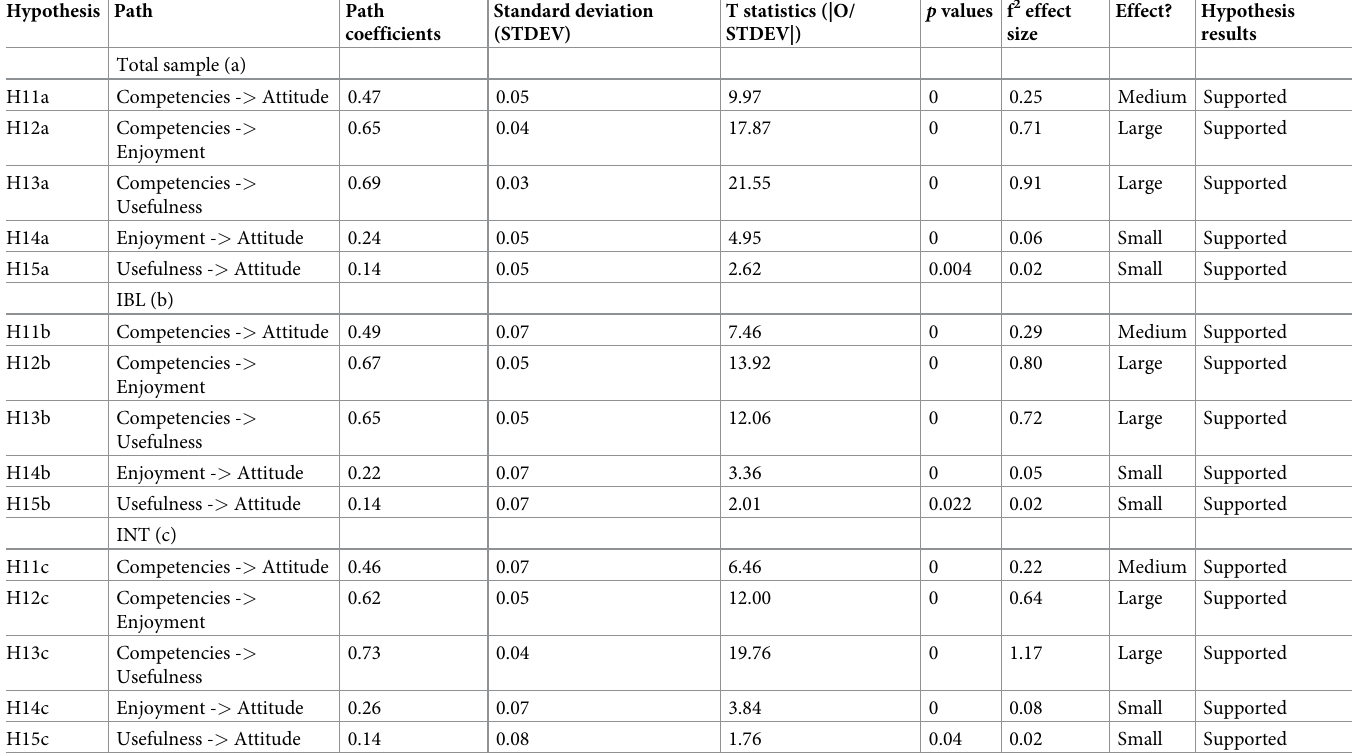
Table 8. Specific direct effects and the effects size evaluation of the exogenous latent variables on the endogenous variable in their direct relationships for the total sample (a), IBL (b) and INT (c) teaching practices. Hypothesis Path